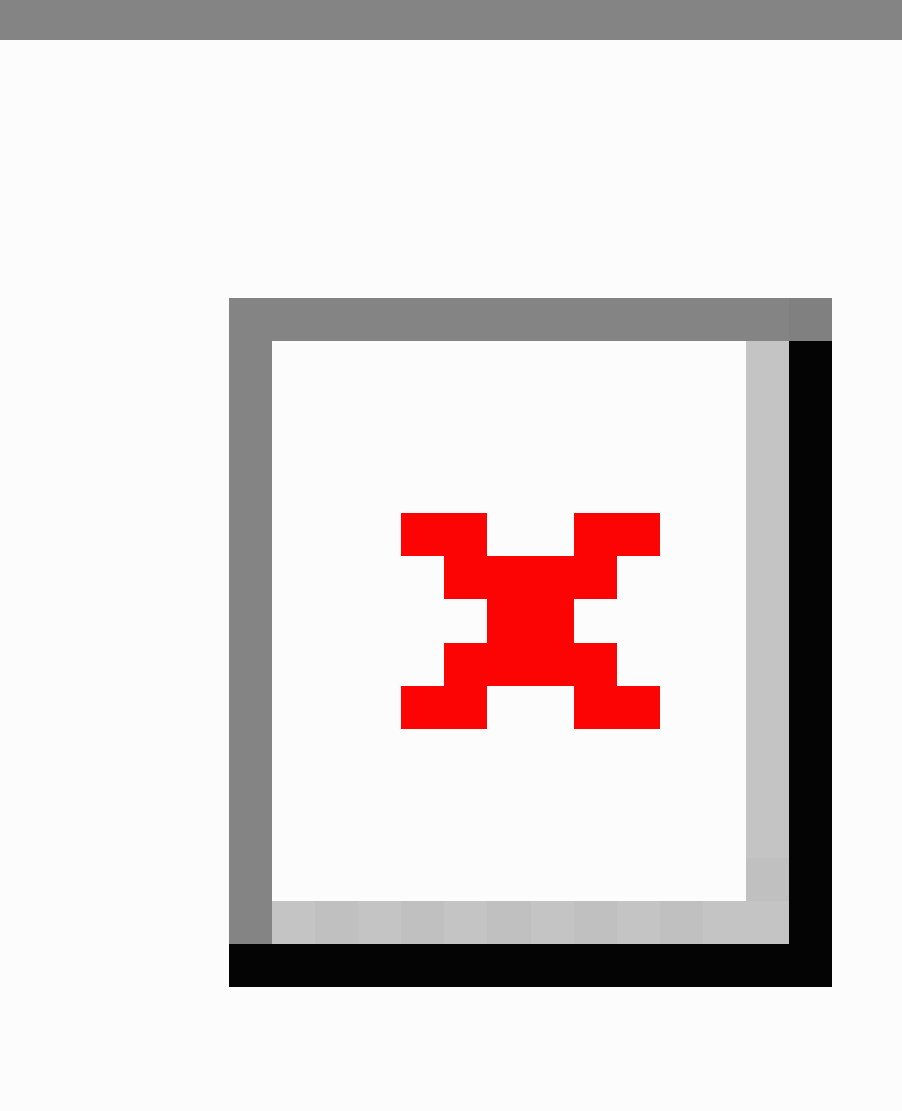
Figure 7. The distribution of netizens’attention to five different types of China-made